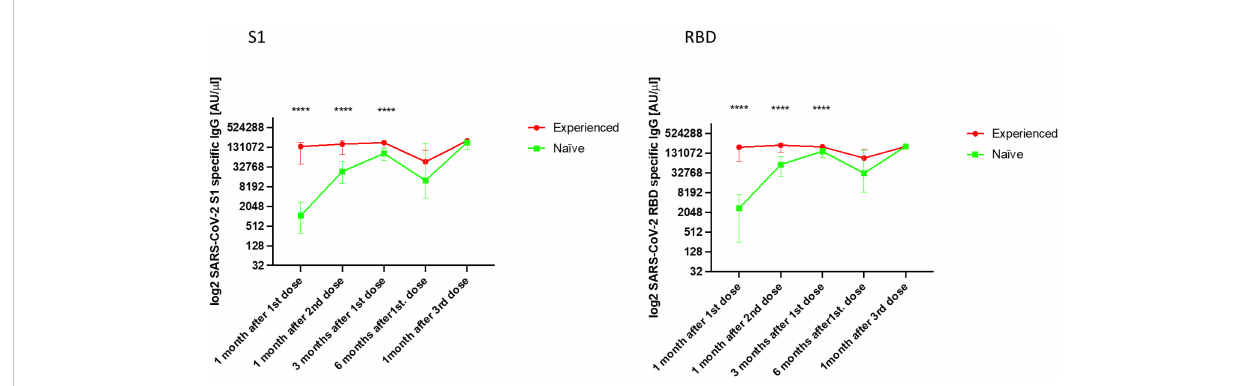
TABLE 1 Median IgG (AU/µl [IQR]) levels in each sampling against the N antigen of SARS-CoV-2 in the group that had previous experience with the virus (experienced) and the group that was not previously infected (naïve).